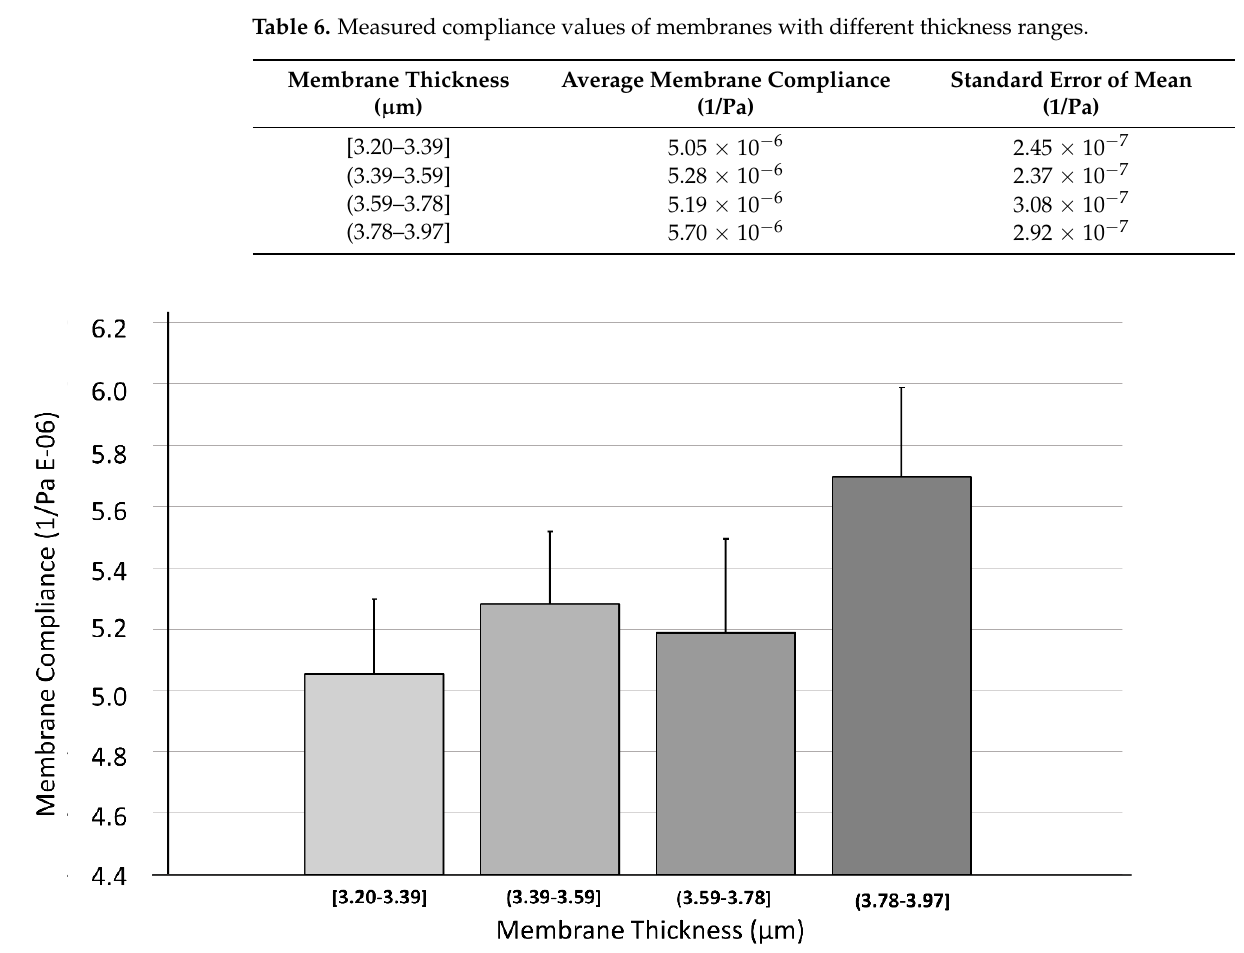
Figure 9. Dependency of membrane compliance on PDMS membrane thickness. Data were checked for normality ( n = 30) using Shapiro – Wilk test. With the help of a histogram, four thickness groups were separated and their average deflection values were calculated for the graph. Error bars represent standard error of mean (SEM) for each group. One-way ANOVA test did not show any difference between the different thickness groups at α = 0 .05.